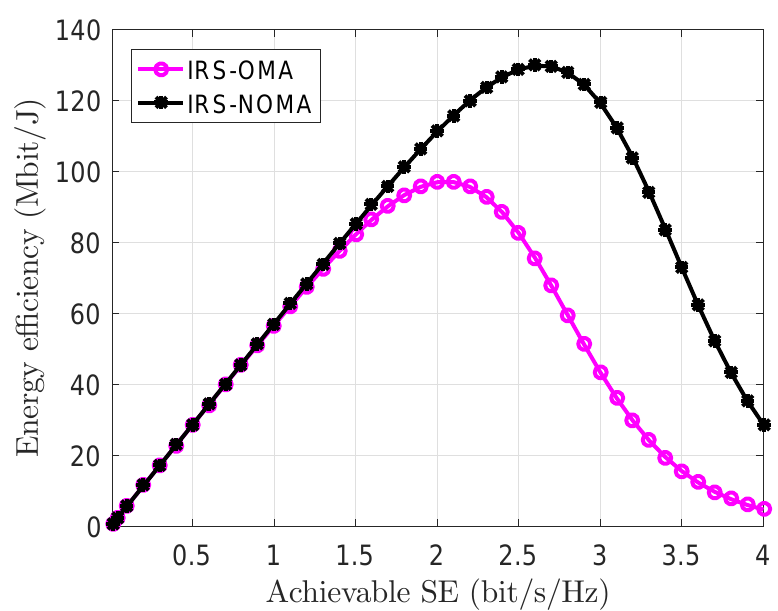
Figure 8. EE-SE trade-off of IRS-NOMA in two